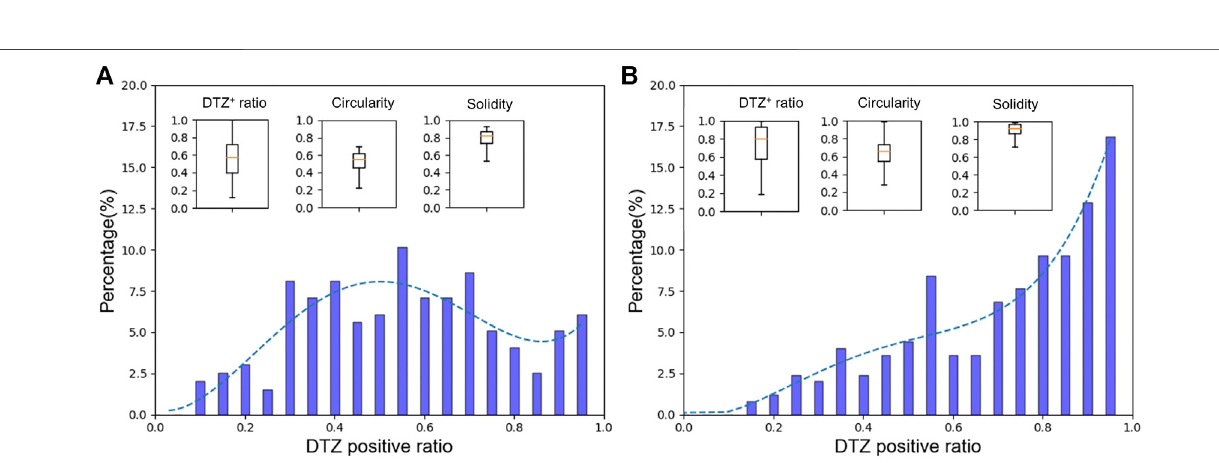
FIGURE8| Circularityandsolidityassessment. (A) Isletcircularitydistribution.Theisletsamplehasanaveragecircularityof0.591 ± 0.127. N (cid:1) 628. (B) Isletsolidity distribution. The islet sample has an average solidity of 0.853 ± 0.107. N (cid:1) 628.